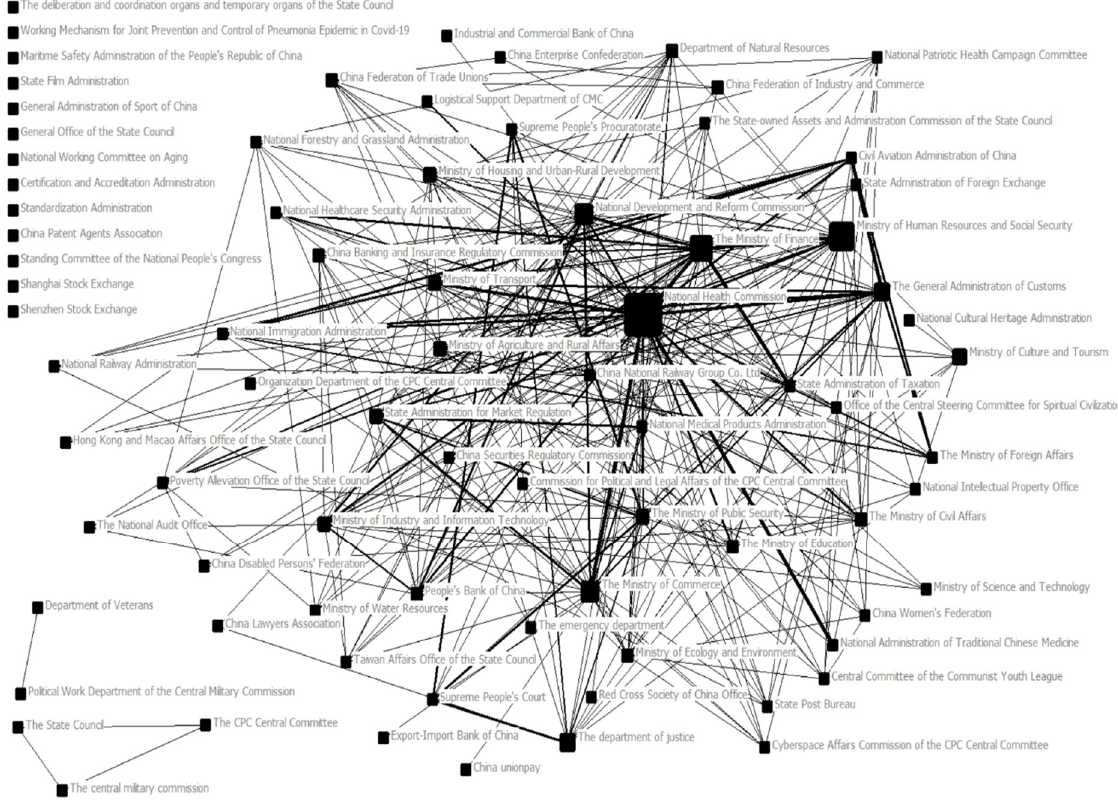
Figure 2. Inter-agency cooperation network of public policy making during COVID-19.